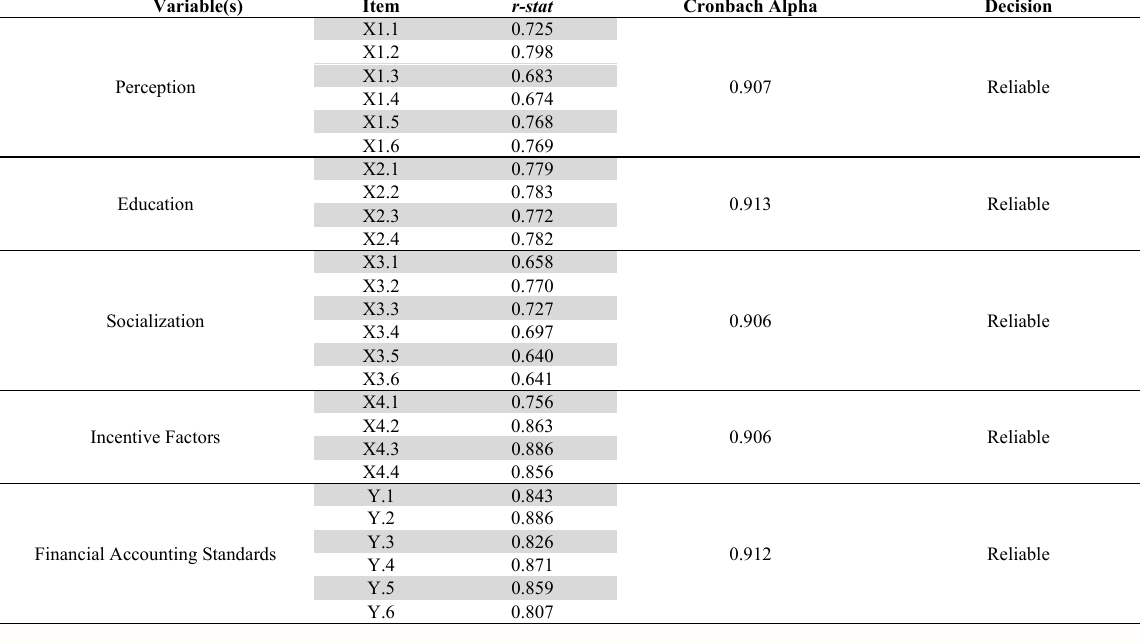
The result of item validity and reliability of measurement